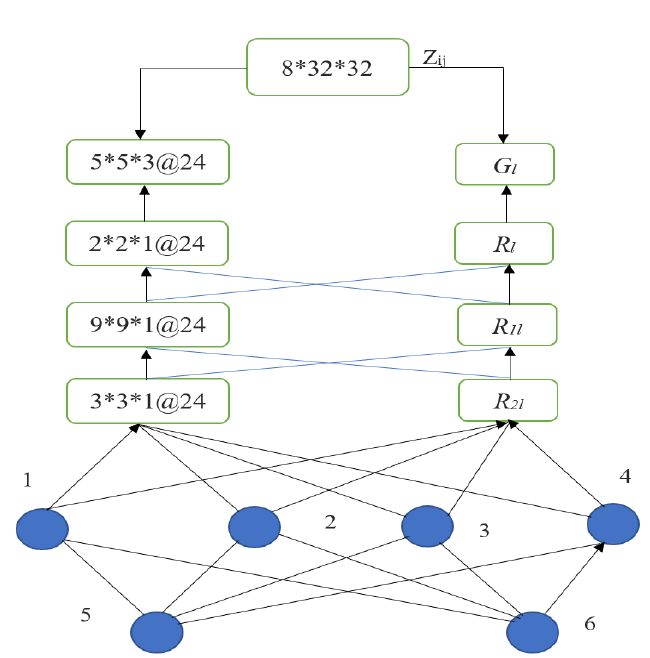
Figure 3. Logical-pool support RNN.